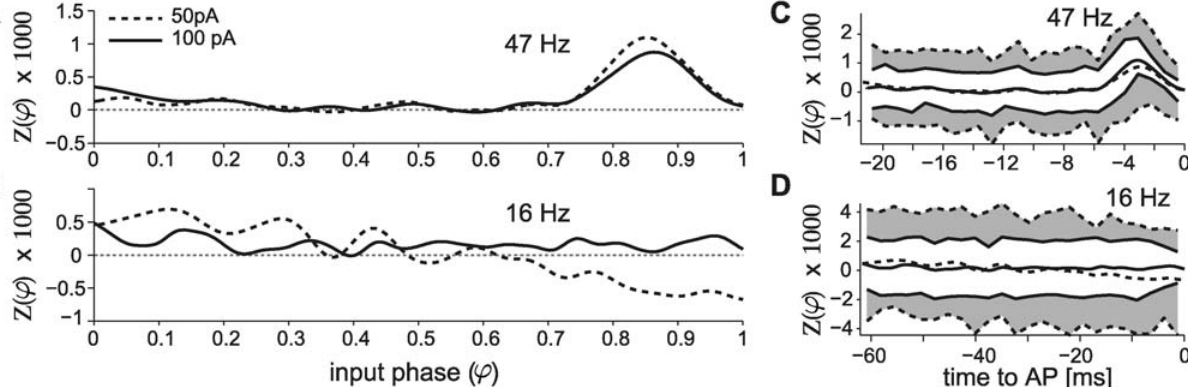
Fig 4. Signal to noise ratio in PRC estimates. PRCs were smoothed and normalized by the total charge of the injected pulse Q = I pulse (cid:1) T pulse . Increasing the amplitude I pulse increased the estimates confidence (A-B), reducing the standard deviation of the PRC raw data points, especially as PCs fire at low firing rates. The plots display the PRC estimates obtained without the PID controller for I pulse = 50 and 100 pA, in the same PC over a comparable number of stimulation trials (i.e., 1911 and 1338 at high firing rates, and 3361 and 3350 at low firing rates, respectively). The smoothed PRCs and their 68% confidence intervals (C-D) are plotted, as a function of time (i.e., τ = ( φ − 1) (cid:1) h ISI i ) by the lines and shaded areas (i.e., dashed/gray for 50 pA and continuous/white for 100